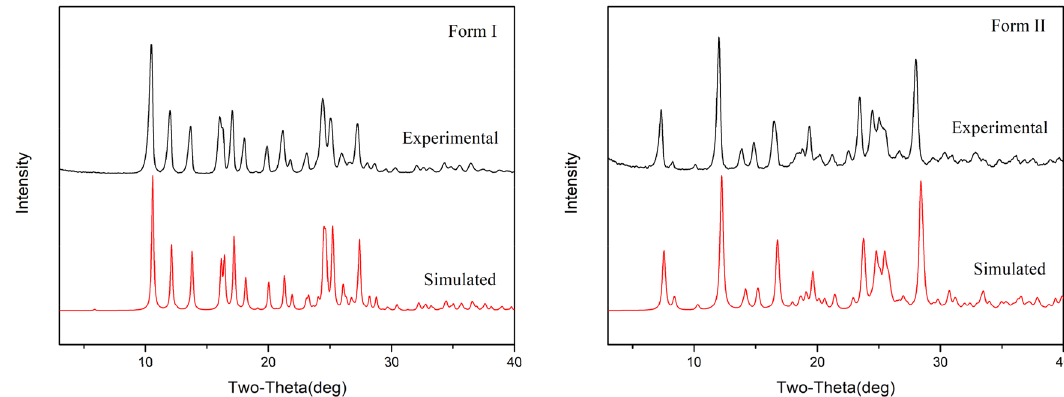
Fig. 9 Simulated and experimental PXRD patterns for mangiferin forms I and II